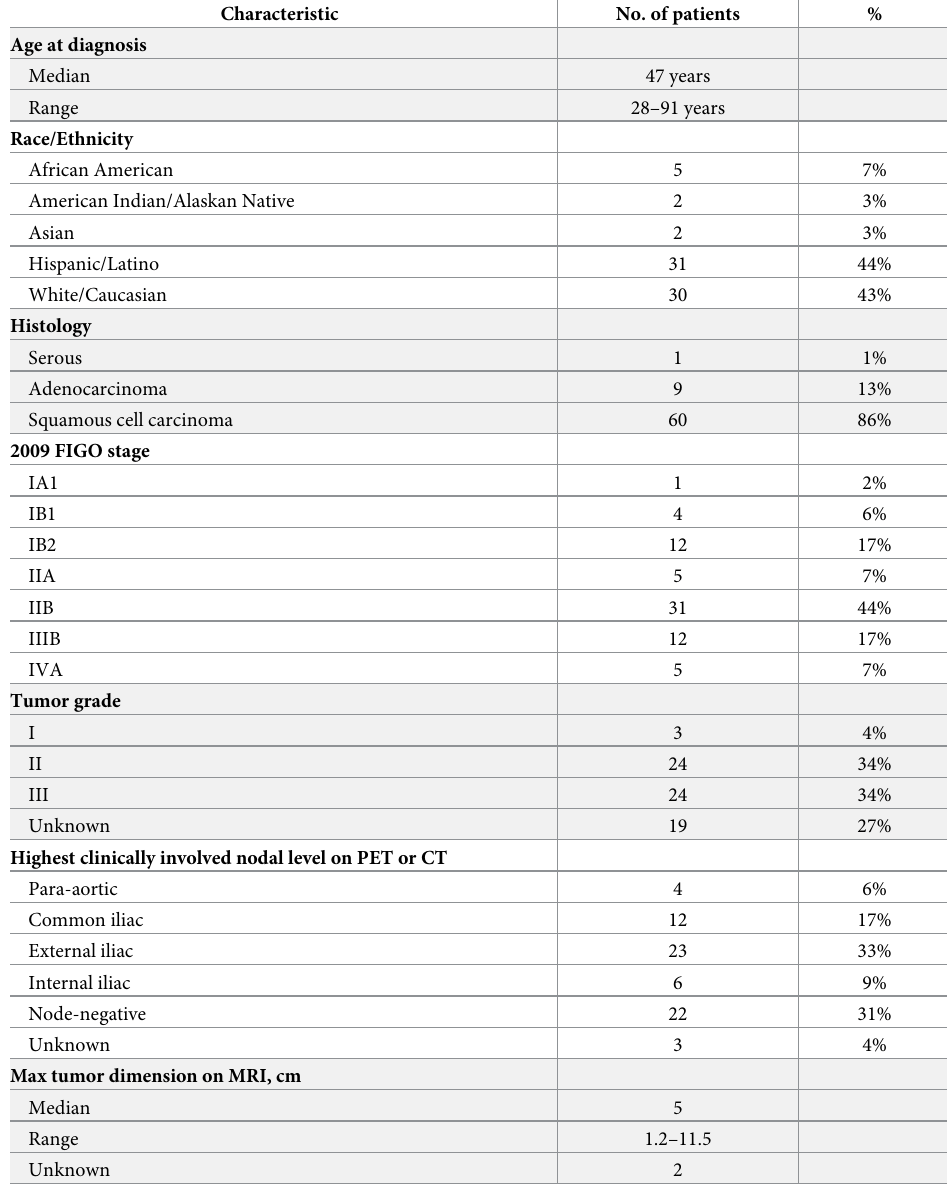
Table 1. Patient characteristics.